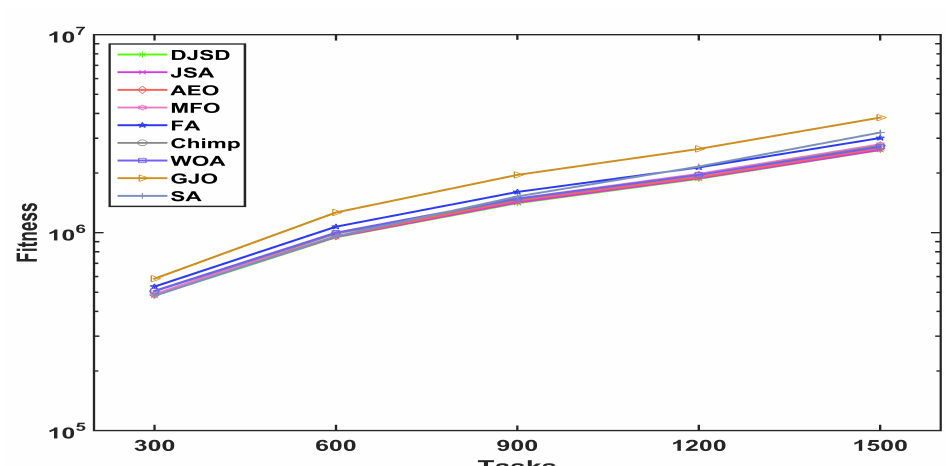
Figure 4. Convergence curve for the synthetic